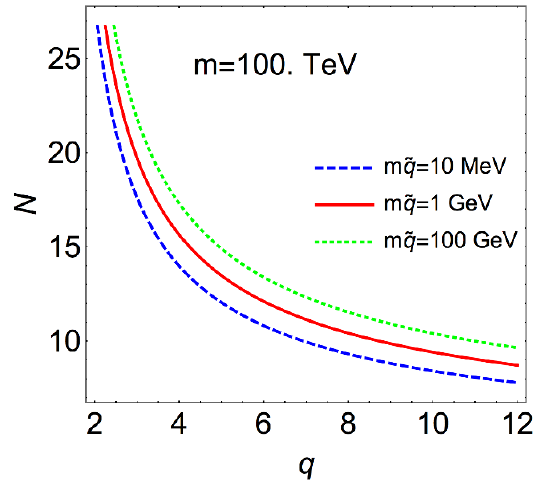
Figure 2 . Contours denoting the values of q and N that produce the observed relic abundance for the fermionic Clockwork model. Here m = 100 TeV and the three contours are shown for three choices of m ~ q = f 0 : 01 ; 1 ; 100 g